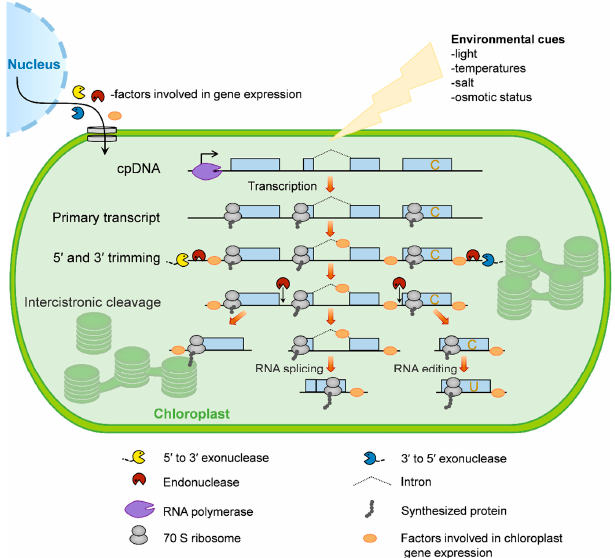
Figure 1. Overview of chloroplast gene expression. In plants, most chloroplast genes are organized as operons and are controlled by single promoters (bent arrow). These genes are transcribed by two distinct types of RNA polymerase: Nucleus-encoded RNA polymerase (NEP) and plastid-encoded RNA polymerase (PEP). The resulting primary transcripts require several processing steps to form mature mRNA, including 5 ′ and 3 ′ trimming, intercistronic cleavage, RNA splicing, and RNA editing. In order for these events to take place, numerous nucleus-encoded proteins are translated in the cytosol and imported into the chloroplast, where they control and/or regulate chloroplast gene expression. Chloroplast gene translation is conducted by bacterial-type 70S ribosomes, which occurs cotranscriptionally. Since the mRNA turnover rate within chloroplasts is slow, most ribosomes function in posttranscriptional steps. Moreover, chloroplast gene expression is involved in responses to environmental cues.